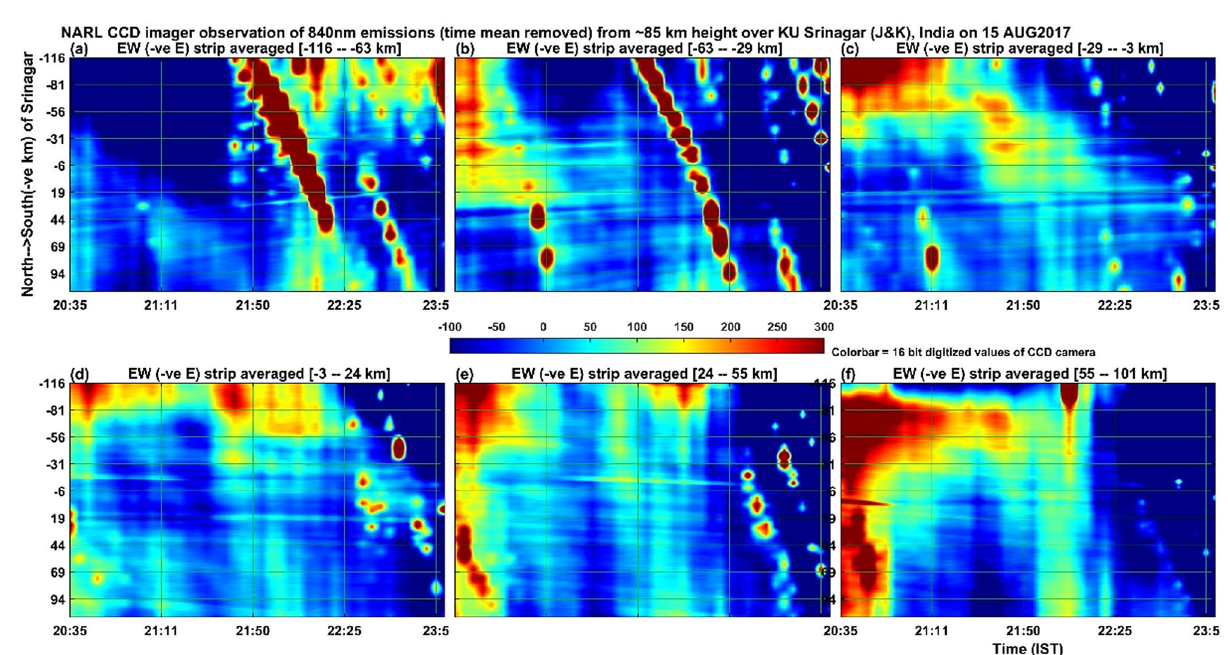
Figure 6. Illustrates the same as the Fig. 4 but for the 840 nm emissions of OH molecules from the height of about 86